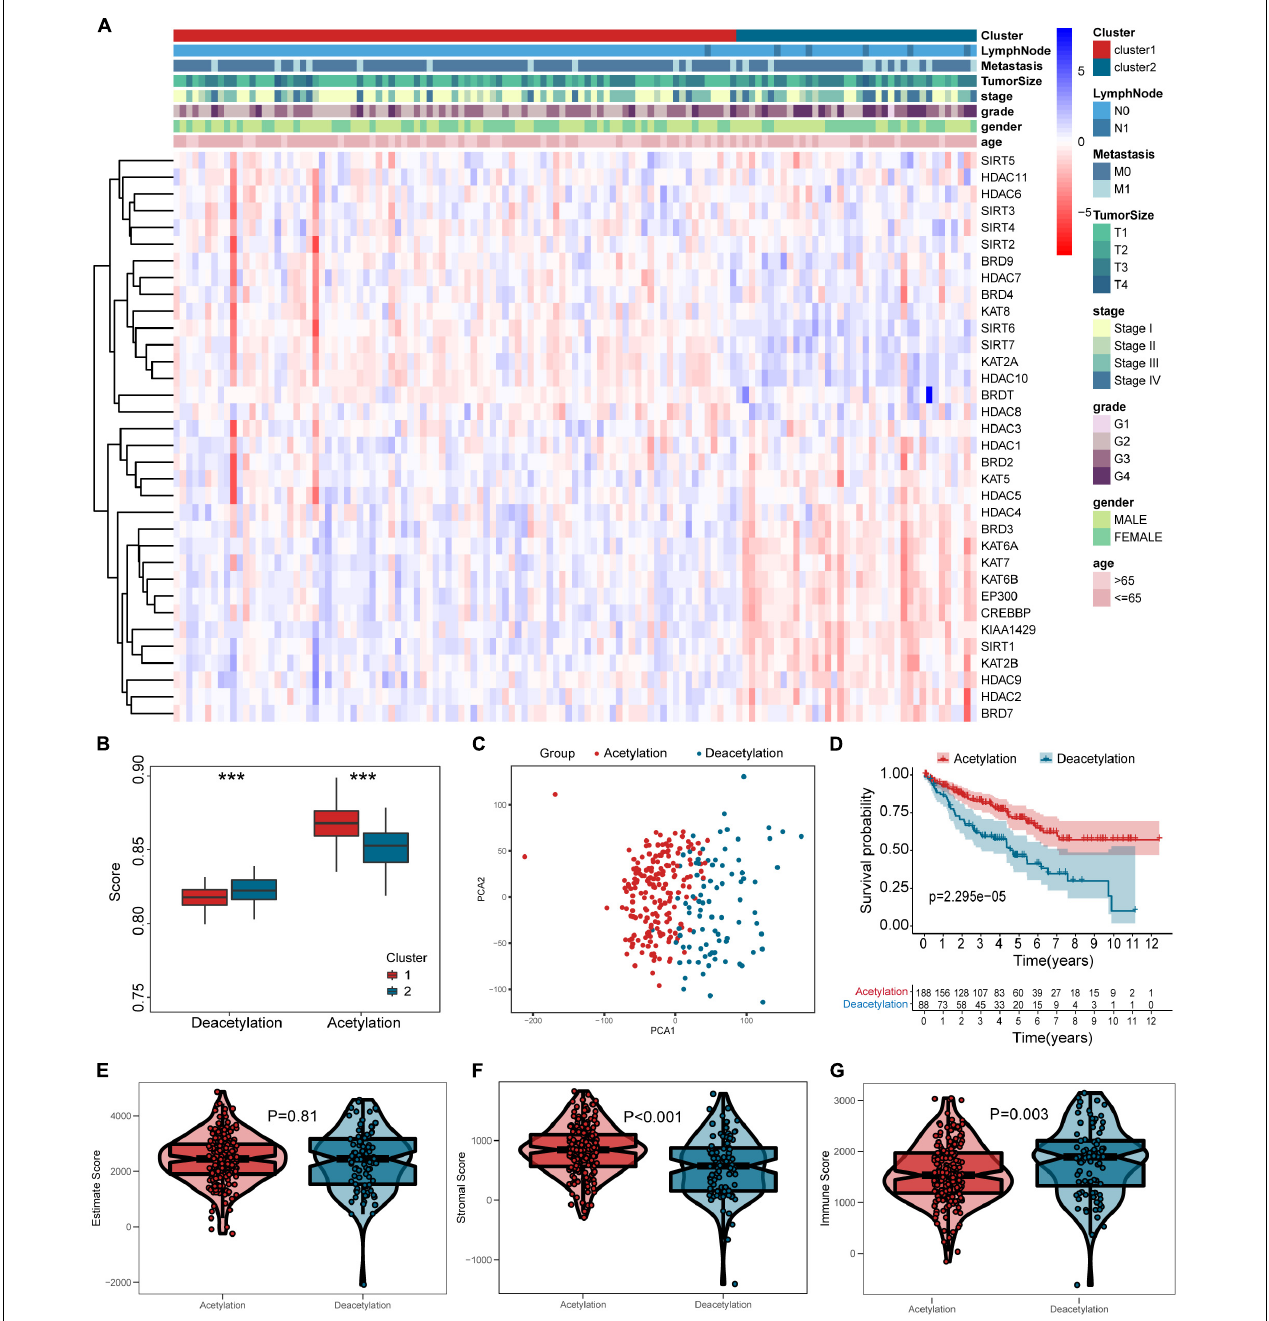
FIGURE 3 | Heatmap and verification of histone acetylation-related molecular subtypes. (A) The heatmap including clusters, clinical parameters, and acetylation-related genes. (B) The definition for cluster based on ssGSEA. (C) Results of PCA. (D) Survival analysis. (E–G) Comparisons of estimate score, stromal score, and immune score between two subtypes, respectively. *** p <